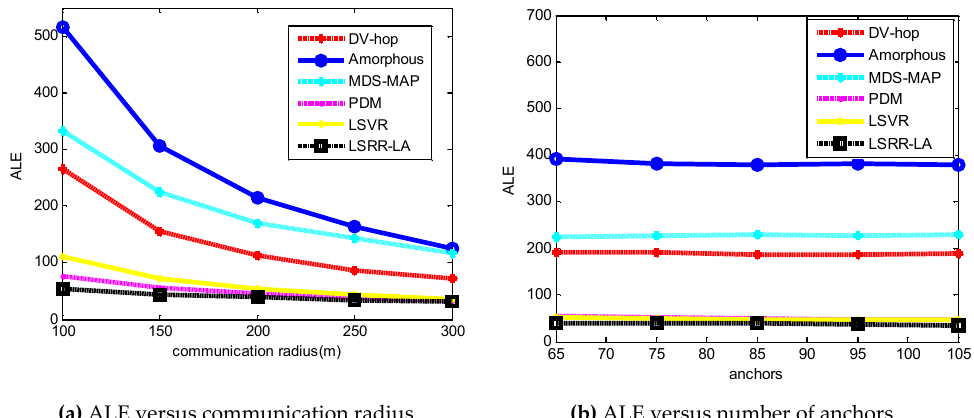
Figure 6. The ALE results of C-shaped random networks.